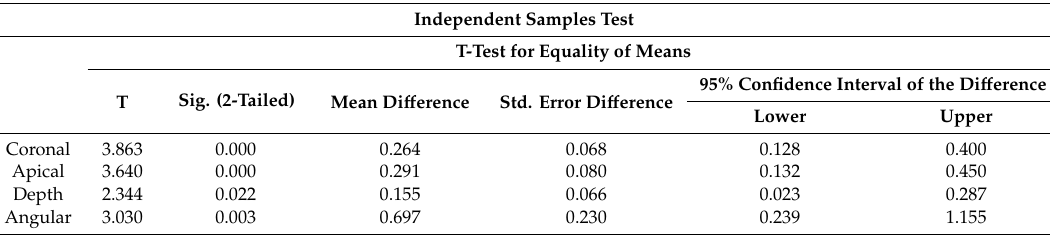
Table 1. Mean di ff erence in the coronal position of implants, the apical position of implants, depth of implants, and angle of implants between the two